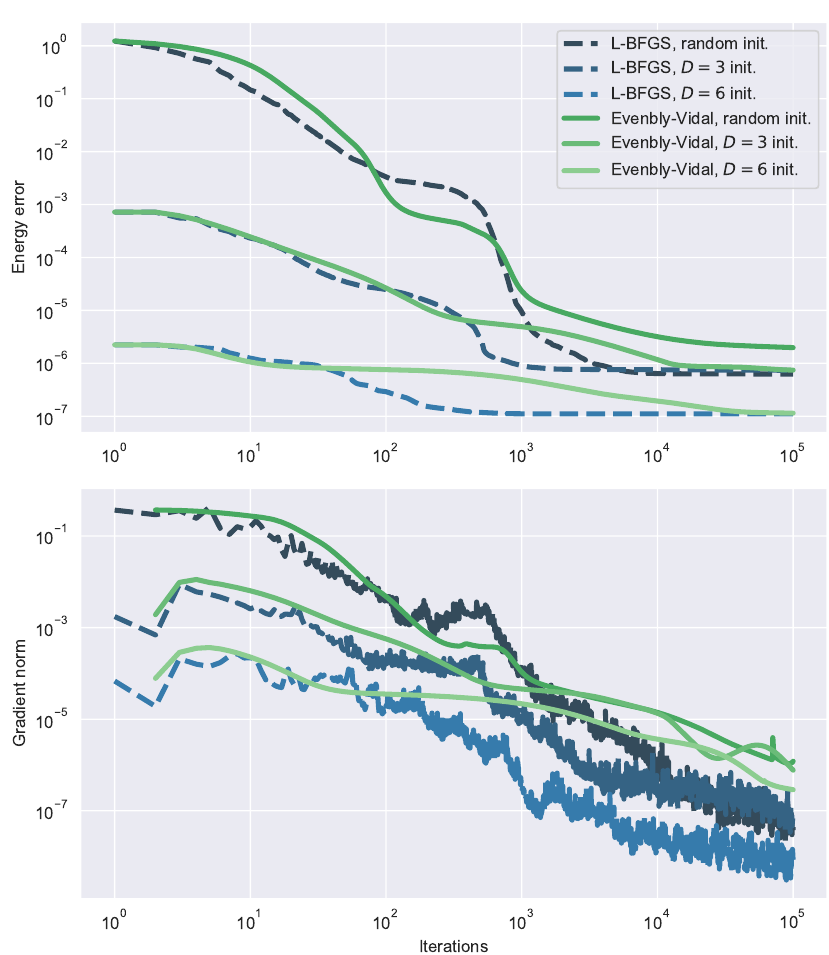
Figure 2: A comparison of convergence in optimising a MERA using the Evenbly-Vidal algorithm (solid green lines) and L-BFGS on Riemannian manifolds (dashed blue lines). Displayed here are the ground state energy error compared to the exact value (top) and the norm of the gradient (bottom). The benchmark model in question is the critical Ising model. In all simulations the MERA is a bond dimension 8 ternary MERA with two transition layers, with the (cid:90) symmetry enforced. For both algorithms three 2 different simulations are shown, corresponding to three different starting points: One was a MERA initialized with random isometries and identity disentanglers, the two others were MERAs optimized to convergence at a lower bond dimension, D = 3 and D = 6, and then expanded to the full bond dimension D = 8. This kind of slow ramping up of the bond dimension can be useful for both speed of convergence and for avoiding local minima. As the energy error plot shows, here, too, some simulations converge to a local minimum instead of the global one. In all cases the convergence speed of L-BFGS algorithm clearly outperforms the Evenbly-Vidal